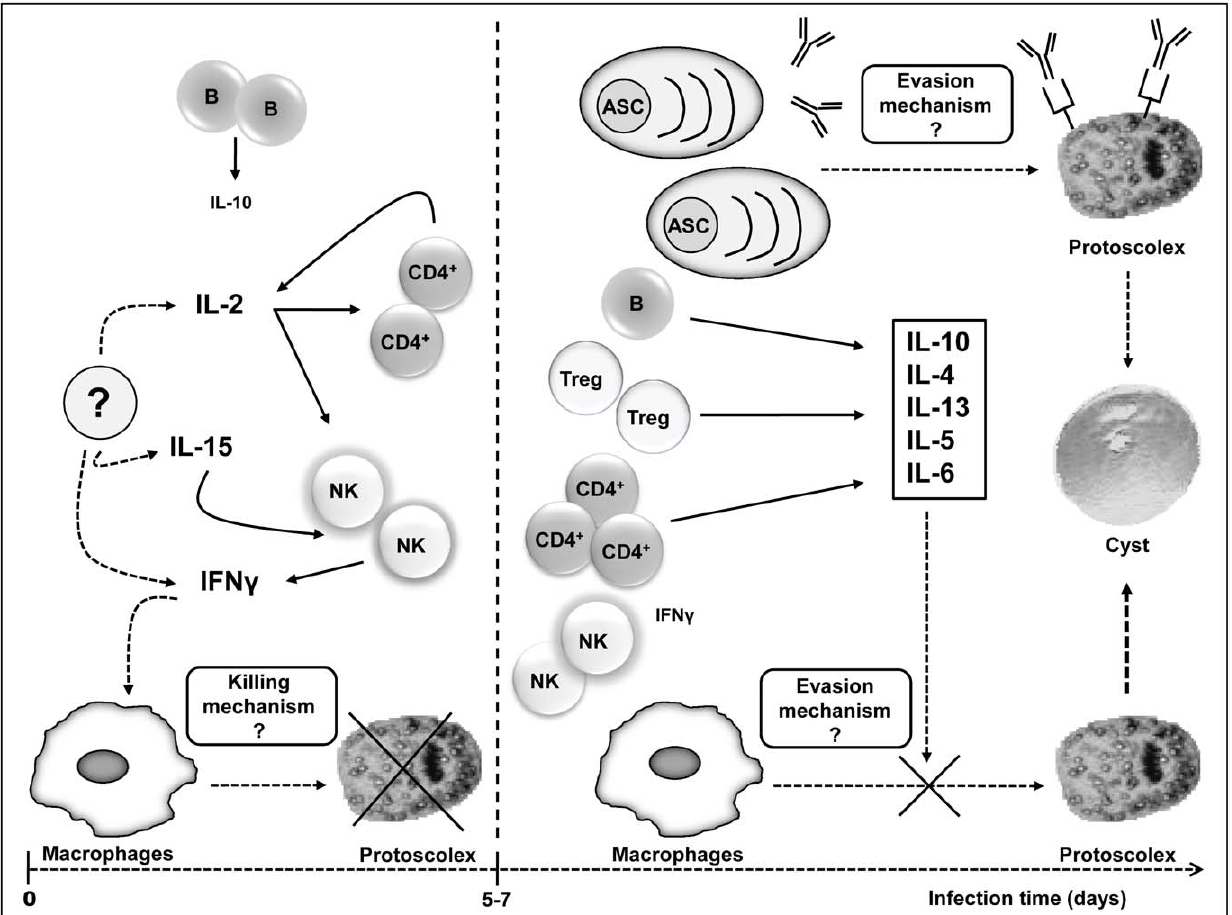
Figure 6. Early immunological phenomena in the peritoneal cavity of infected mice. After ip inoculation of protoscoleces into Balb/c mice approximately only 10% of parasites finally develop into hydatid cysts. Therefore, early immune responses although not optimal to prevent